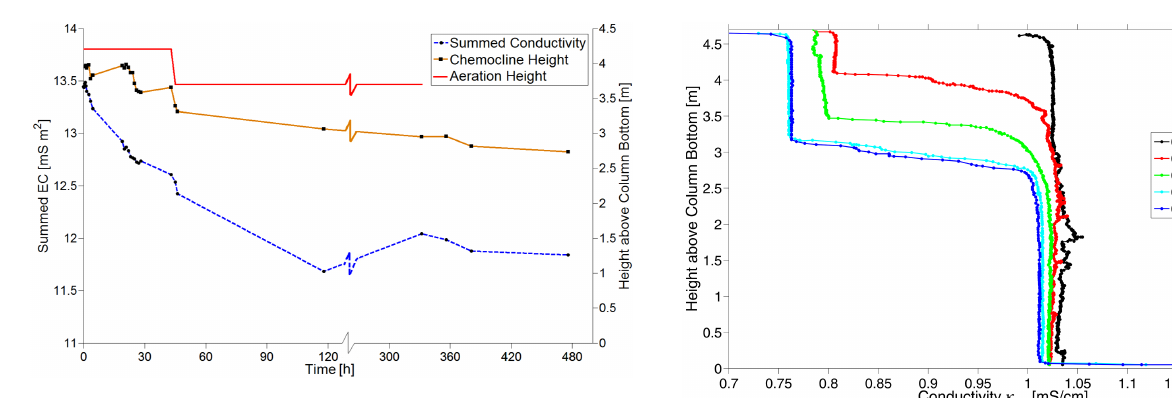
Figure 4. Temporal dynamics of chemocline height and summed conductivity (EC) during the column experiment. The scale break- age indicates the end of the hourly range sampling period of the experiment.